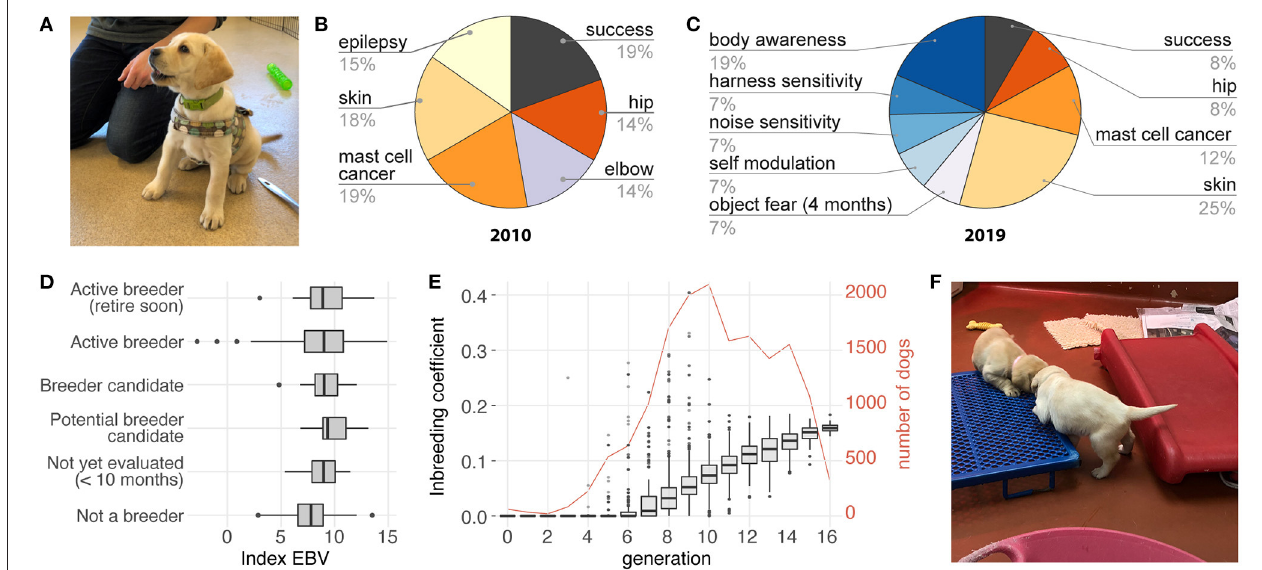
FIGURE 3 | Implementing EBV selection at Guiding Eyes for the Blind. (A) The behavioral phenotypes are collected using the Behavior CheckList scored by trained observers during standardized tests and assessments starting at 2 months of age, and continuing through training until about 26 months of age. (B) The selection index, which weights each trait based on its importance to the breeding program, has changed over time to include more behavioral phenotypes. (C) The current index includes about 50% behavioral and 50% health traits. (D) The rate of genetic improvement can be monitored by reviewing the selection index scores for the current population of dogs. Here, dogs not used for breeding have, on average, the lowest scores, while active breeders, including those nearing retirement, have the highest scores, consistent with the increasing genetic improvement expected in a successful breeding program. If genetic improvement plateaus or worsens, the genetic model, data quality, change in testing protocols or criteria, weighting in the index and other influences are reviewed and corrective action taken. (E) Inbreeding is minimized by selecting mate pairs that maximize diversity, and by limiting the number of progeny produced by any single individual. Between generation 8 and 16, average inbreeding coefficient increased from 3.4 to 16%, corresponding to an increase of 1.6% per generation. (F) To produce high-performing working dogs, environmental factors that influence success must also be addressed. At Guiding Eyes for the Blind, for example, kennels with nursing puppies are enriched with different surface textures, noises, novel objects, and other experiences the puppies will need to be familiar with as working dogs. Image credits (A,F) : Elinor K.